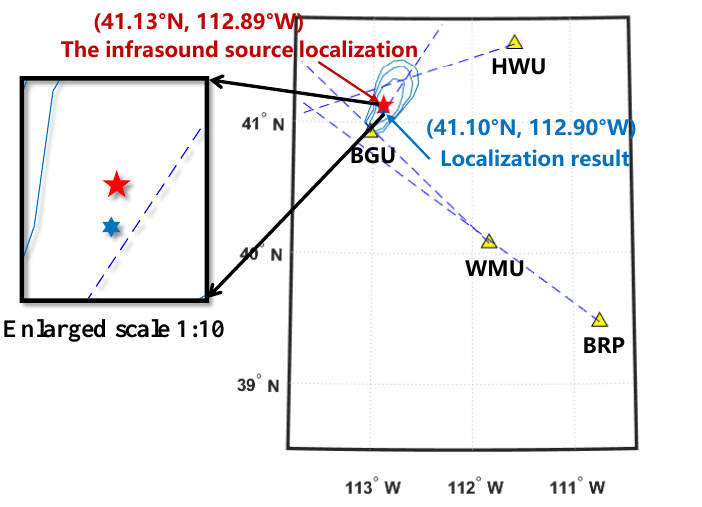
Figure 13. The localization result of the infrasound source by fusing the SBL arrival azimuth estima- tions. (The three blue contour curves are credibility contour curves with Bayesian credibility values of 0.75, 0.90, and 0.95, respectively; the red pentagram indicates the location of the infrasound source; the blue hexagram indicates the distributed array localization results; and the enlarged scale is